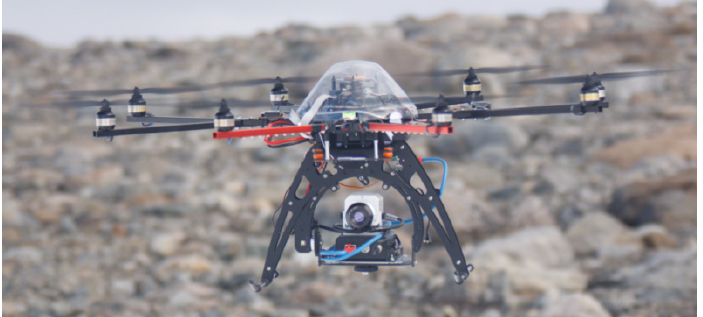
Figure 2. Oktokopter fitted with FLIR Photon 320 Thermal Infrared camera with Ethernet module mounted